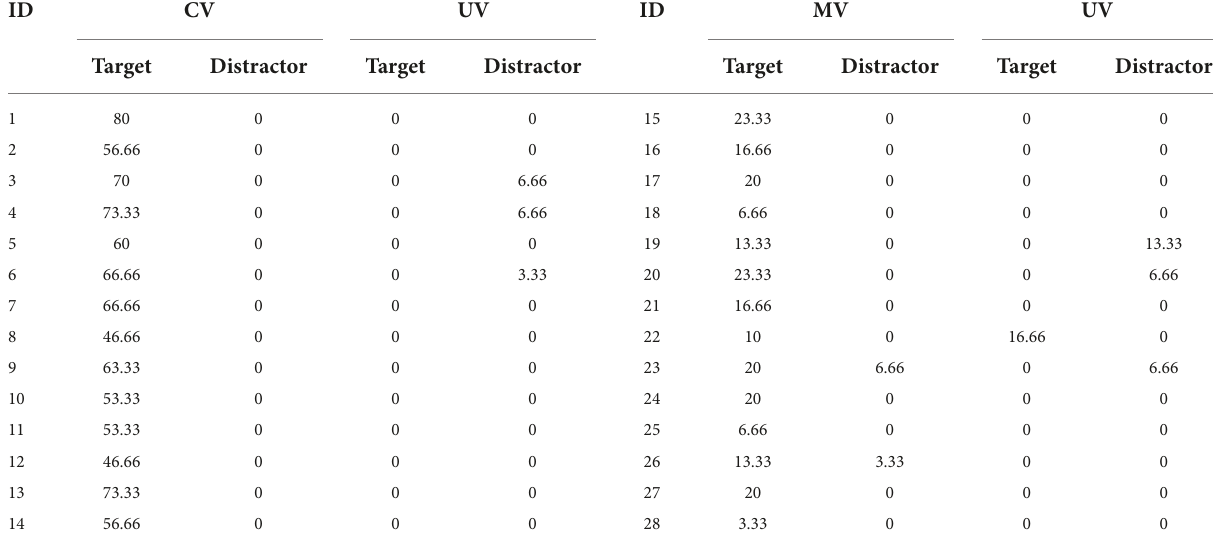
TABLE 2 Association strength between targets and